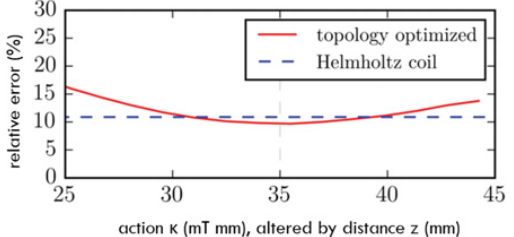
Figure 5. Calculated relative error of the field homogeneity, as a function of the action κ being altered by changing the distance between the permanent magnets.